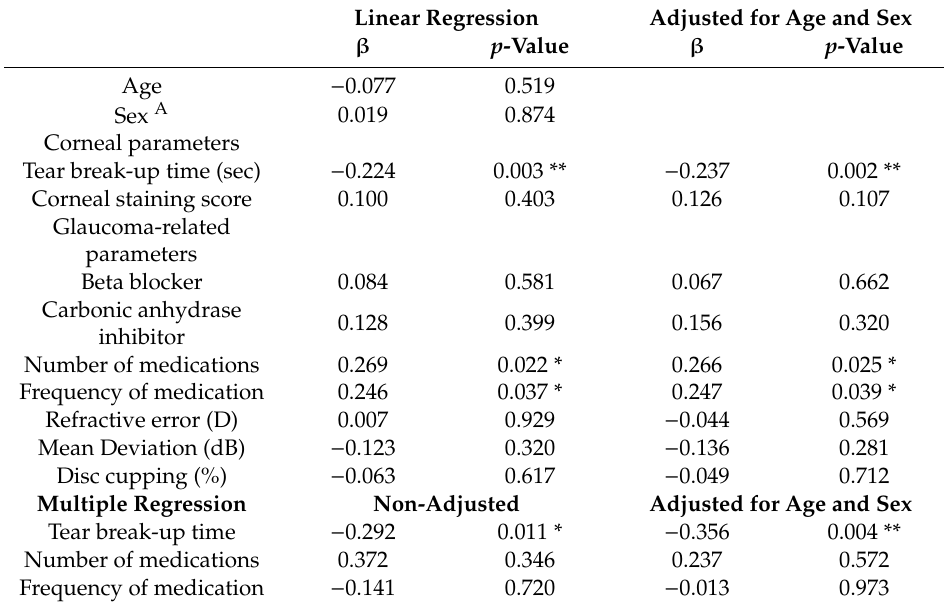
Table 3. Regression analysis of the magnitude of IOP and parameters. Linear